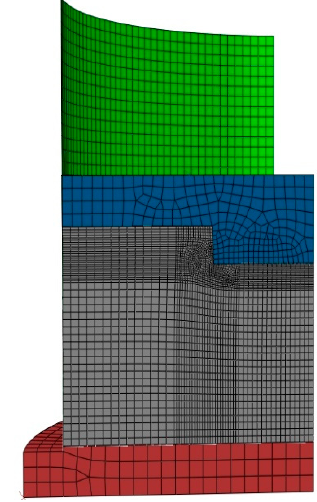
Figure 24. Layers used to compare numerical and experimental results for the slot geometry. Figure 22. CAD model for the test with the slot (m).